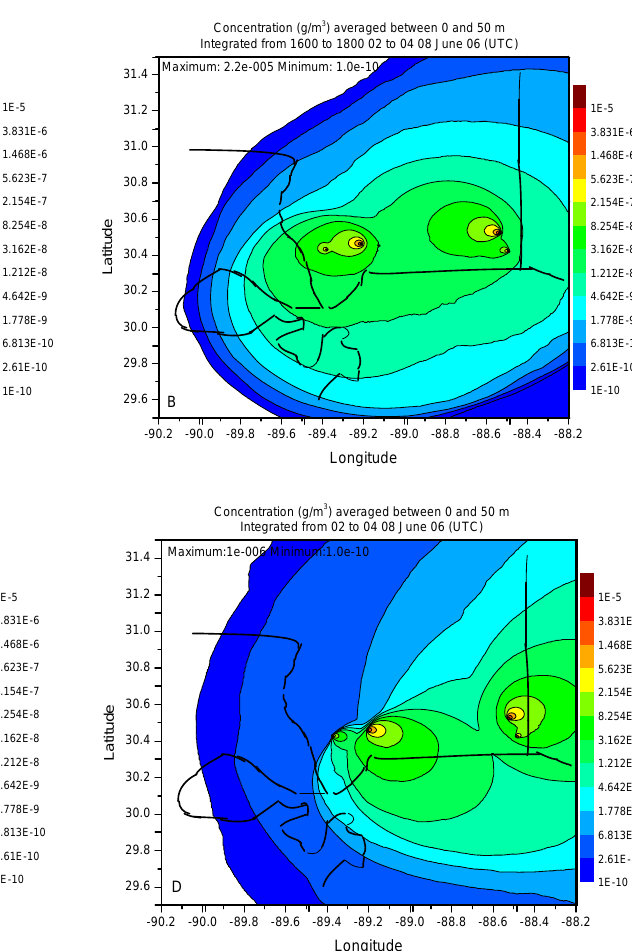
Figure 7. Simulated SO plume concentration distribution using FNL data at 08-10 UTC, 2 01 June 06, 16-18 UTC 01 June 06, 02-04 UTC 02 June 06 and 20-22 UTC 02 June 06